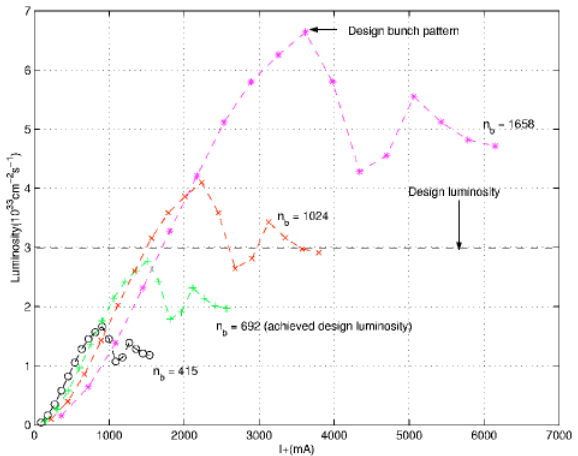
FIG. 5. (Color) Peak luminosity affected by the damping time of the LER with 605 bunches. The circles represent the simu- lation result and the dashed line represents the fitted curve of (cid:2) 2 0.75 2081 (cid:1) t 1 t